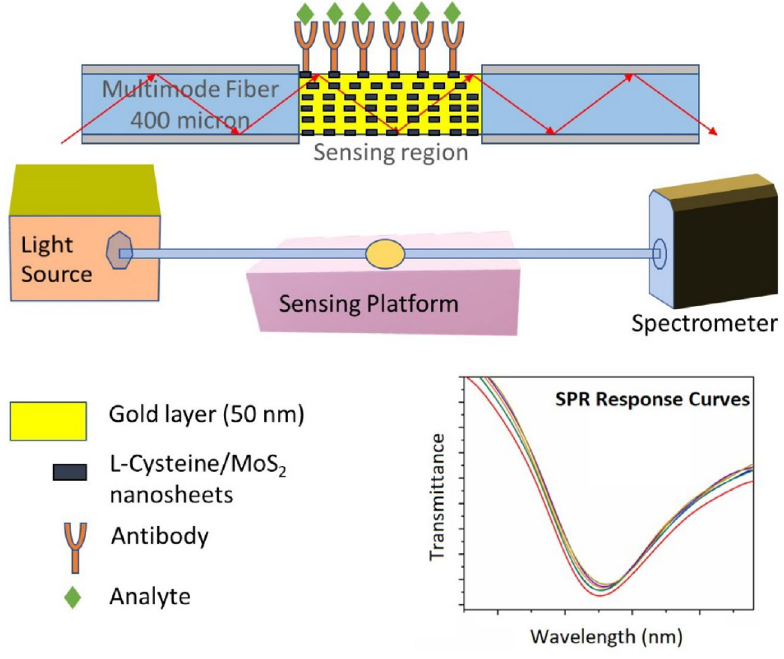
Figure 1. Experimental setup of the MoS 2 modified OF-SPR